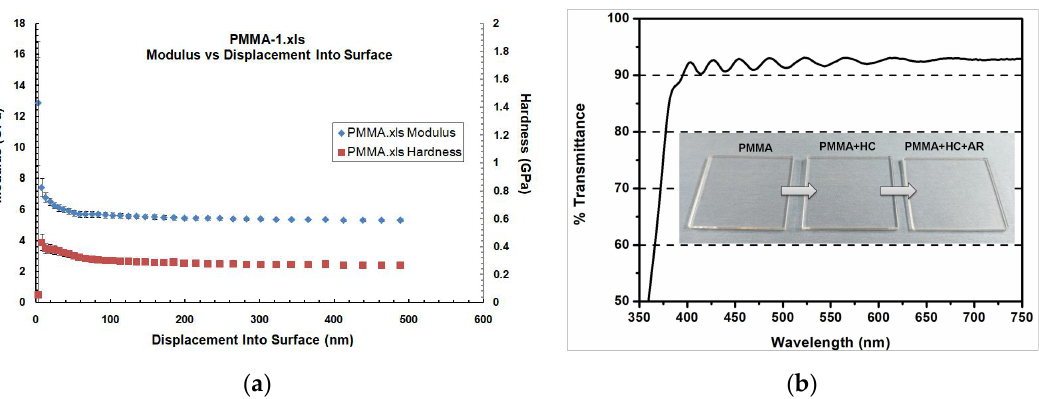
Figure 2. ( a ) Hardness and modulus of the hard coating obtained from nano intender; ( b ) Transmittance of PMMA with HC and two-side AR coatings.